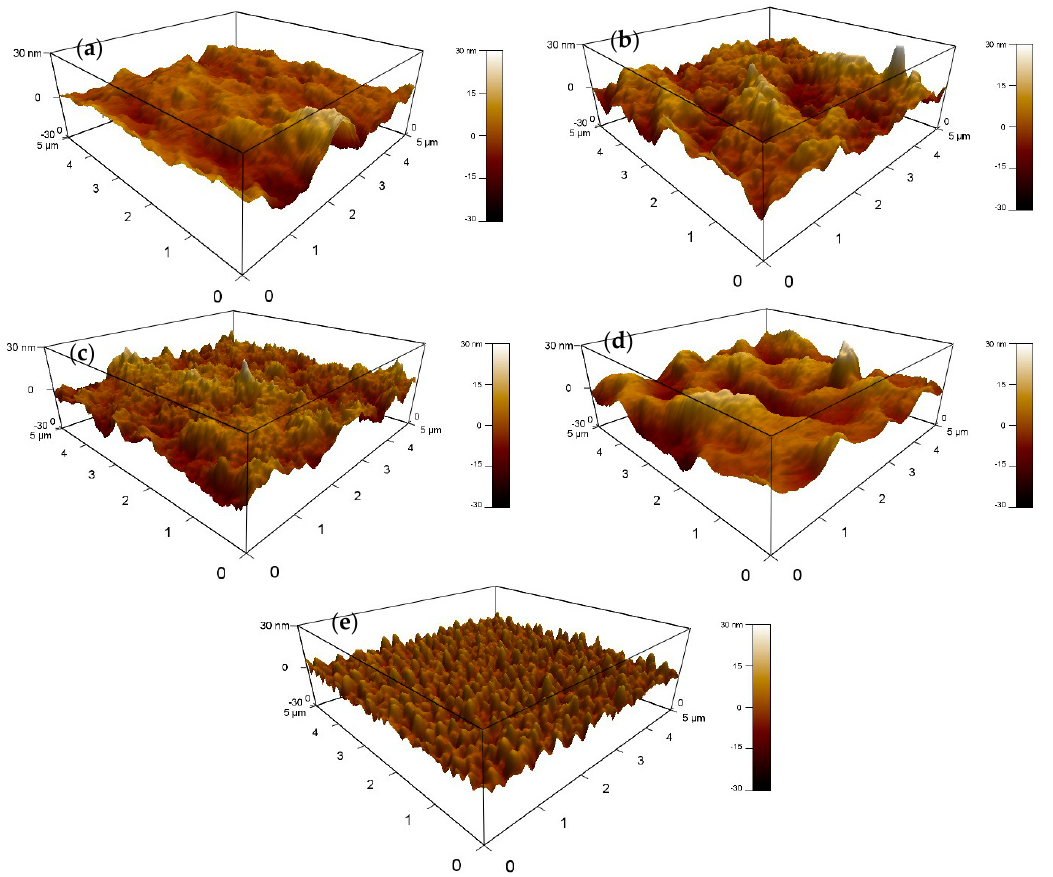
Figure 6. AFM 3D height images ( a – e ) for ternary blends of P3HT:PTT-DTNT-DT:PC 61 BM with 1:0:1, 0.90:0.10:1, 0.80:0.2:1, 0.70:0.30:1, and 0:1:1.